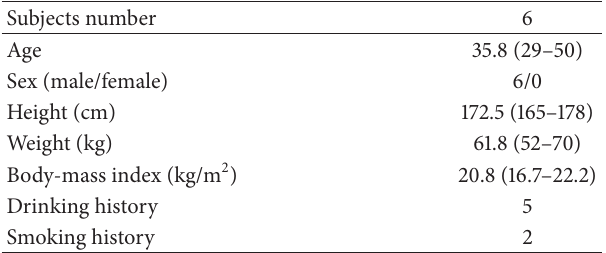
Table 1: Characteristics of the